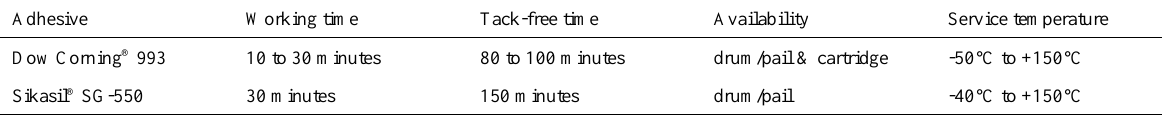
Table 1: Selected specifications for the investigated structural silicones according to Dow Corning (2014) and to Sika (2016).